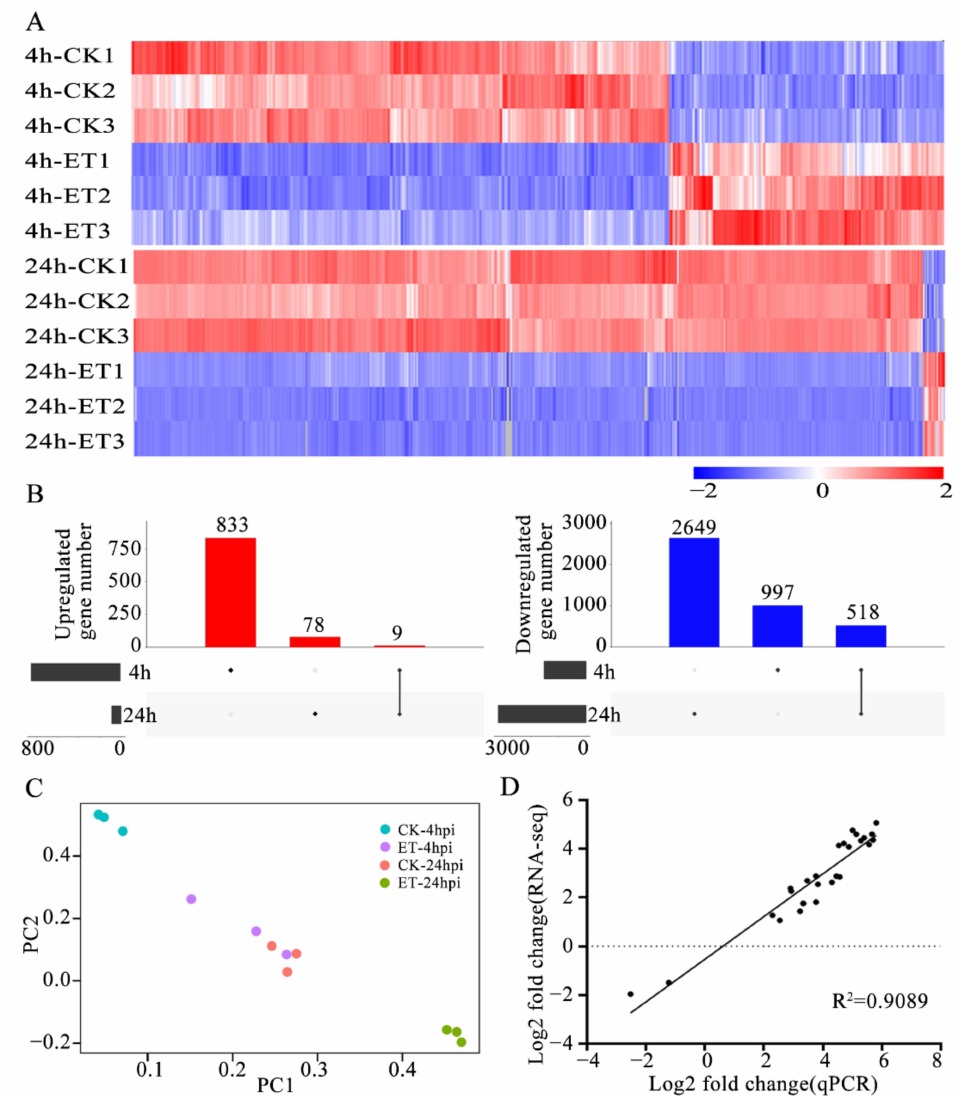
Figure 2. Macroscopic analysis of the transcriptome of C. gloeosporioides regulated by ET. ( A ) Heatmap analysis of differential genes between the CK and ET treatment groups at 4 hpi and 24 hpi. ( B ) UpSetR visualizations of intersections between the upregulated and downregulated differential genes of the CK/ET treatment groups at 4 hpi and 24 hpi. ( C ) Principal component analysis of the CK-4hpi, ET-4hpi, CK-24hpi, and ET-24hpi transcriptome data. ( D ) Correlation of gene expression values obtained by RNA-seq and qRT-PCR analysis with 27 genes, and an R 2 value of 0.9089 was obtained by comparing the results obtained with the two